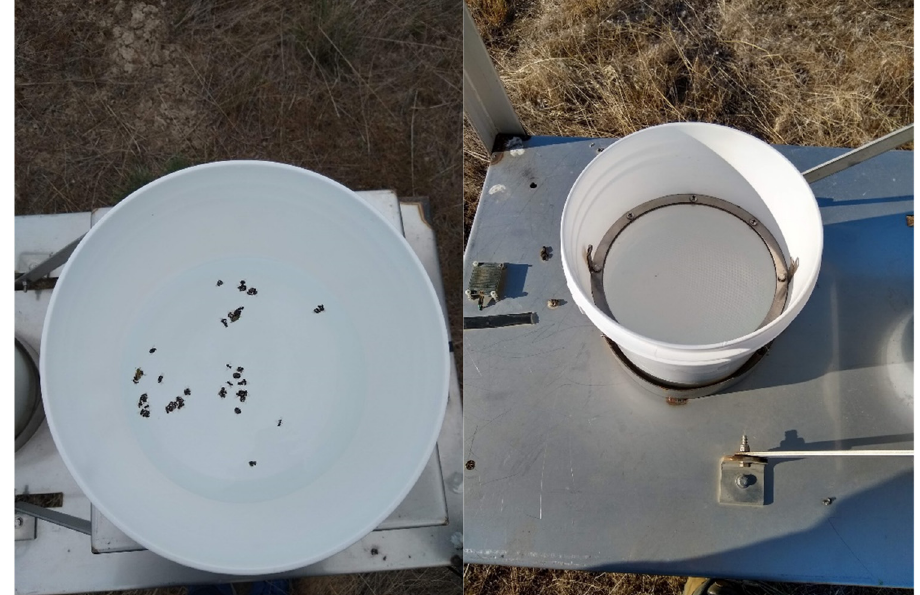
Figure 5. A sample bucket at the Mosida site without screens after two days ( left image) and with screens after one week ( right image). The screens significantly lower the number of large objects in the sample.